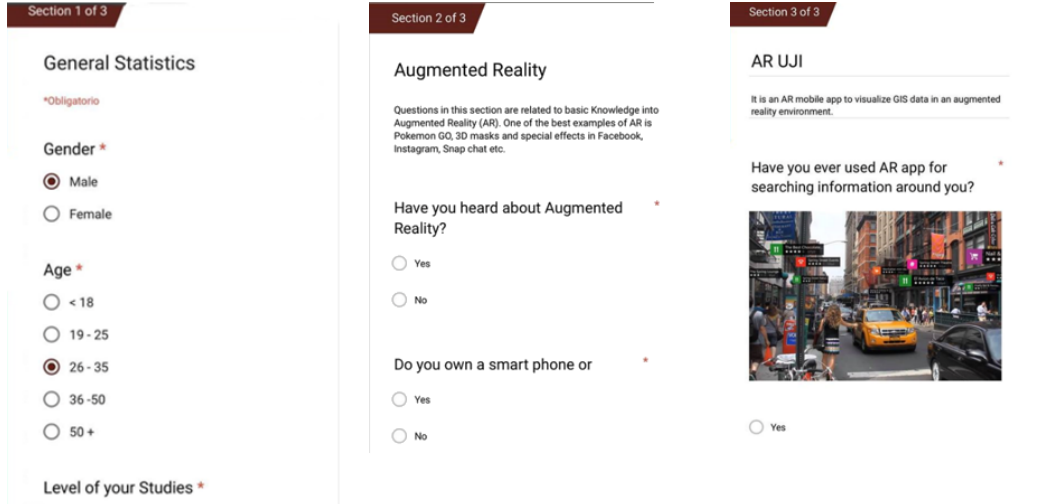
Figure 5. Sample of the questionnaire for discovering user profile and evaluation of the app.